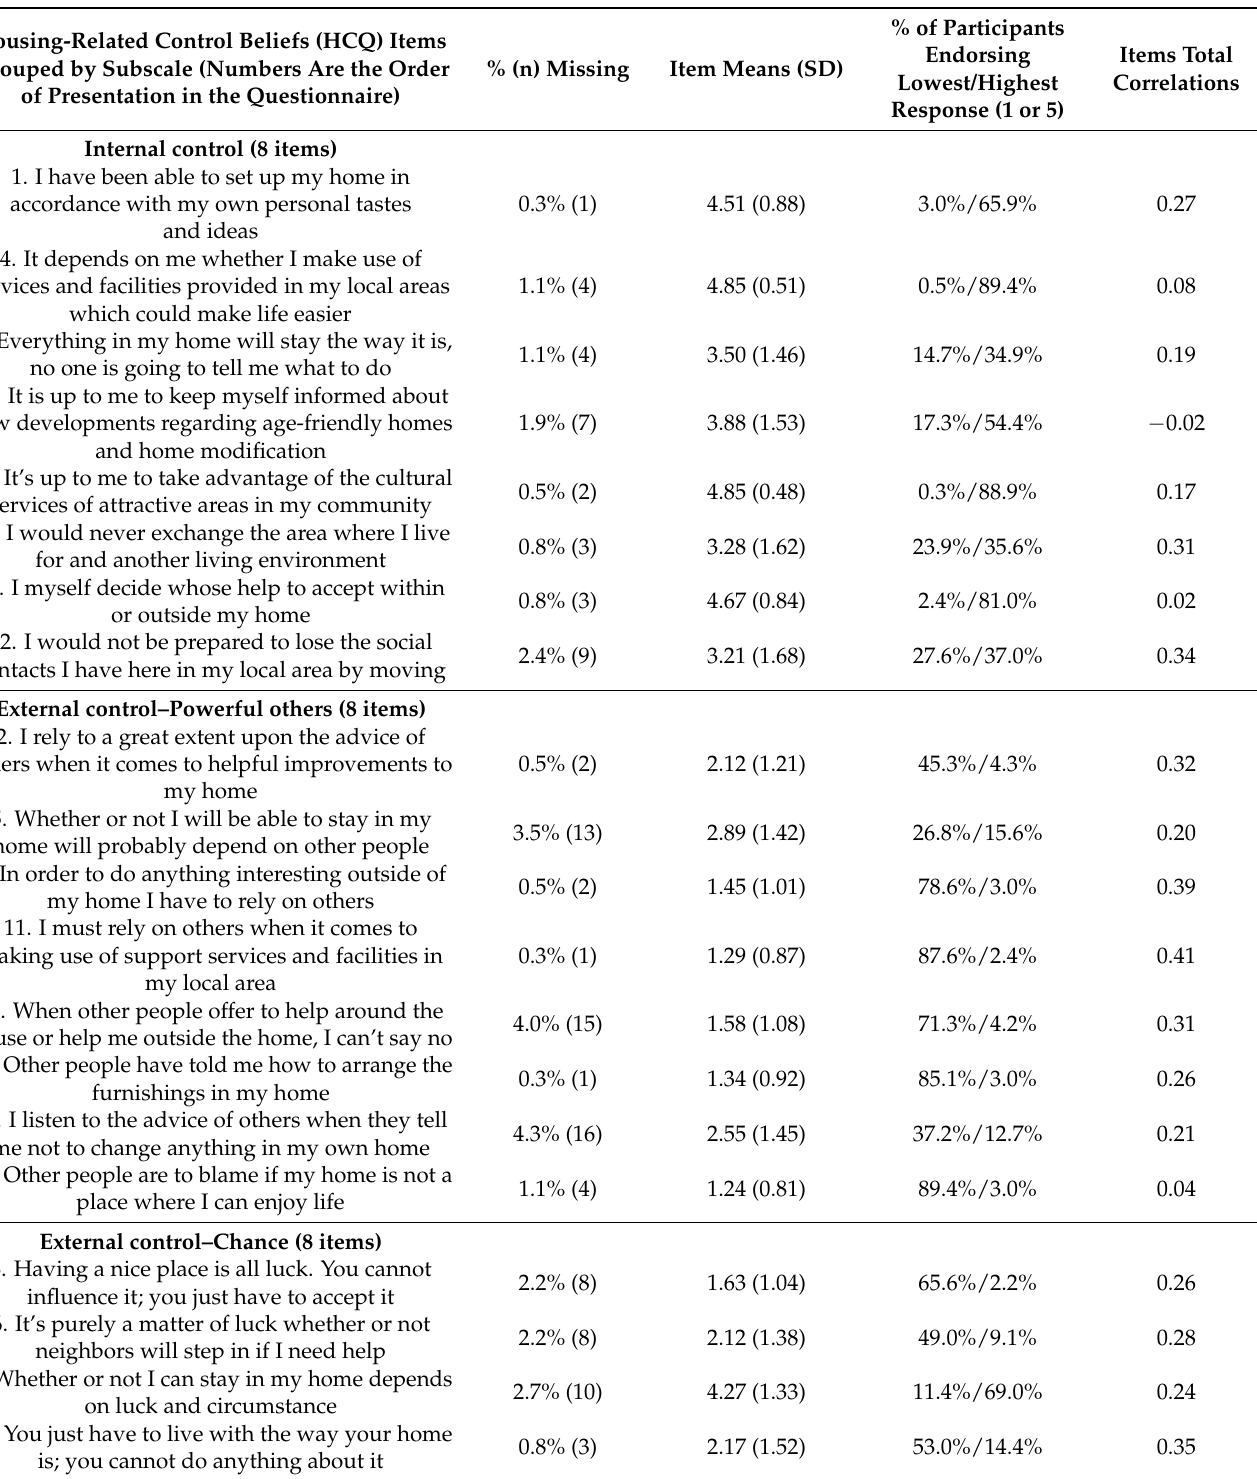
% (n) Missing Item Means (SD)